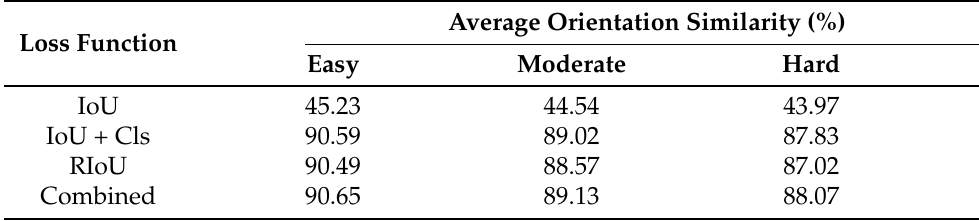
Table 4. Average orientation similarity performance with four loss function strategies.